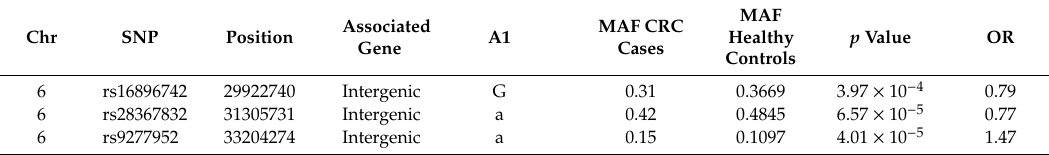
Table 2. SNP association values (only p values < 10 − 3 are shown) based on the allele frequencies characterized for the CRC patients vs. healthy